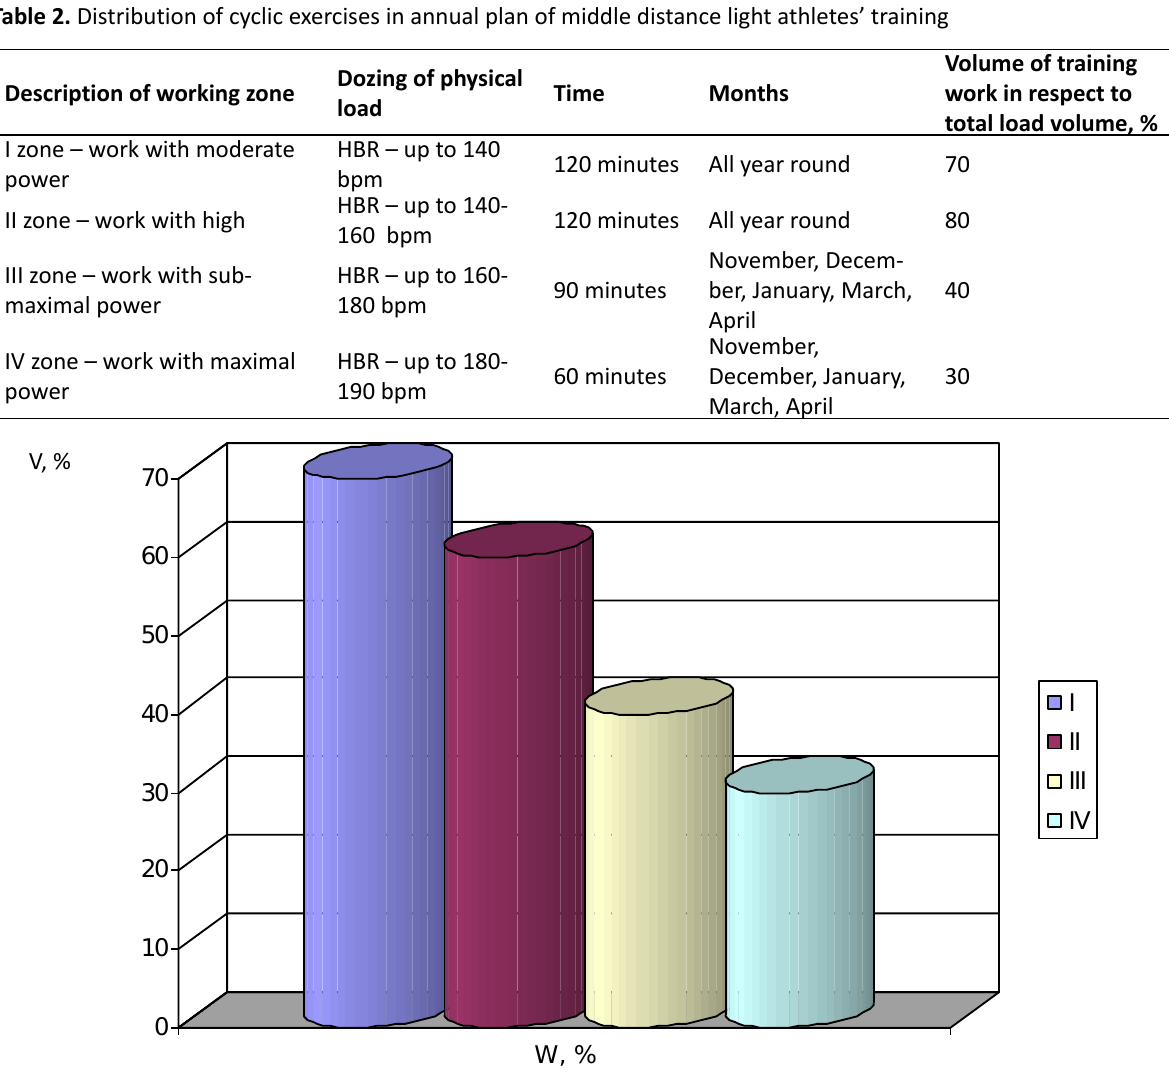
Fig. 2. Distribution of physical load in light athletic sportsmen’s annual training plan: I, II, III, IV – zones of work; V – volume of cyclic load; I zone – work with moderate power; II zone – work with high power; III zone – work with sub- maximal power; IV zone – work with maximal power; W, % - volume of training work in respect to total load